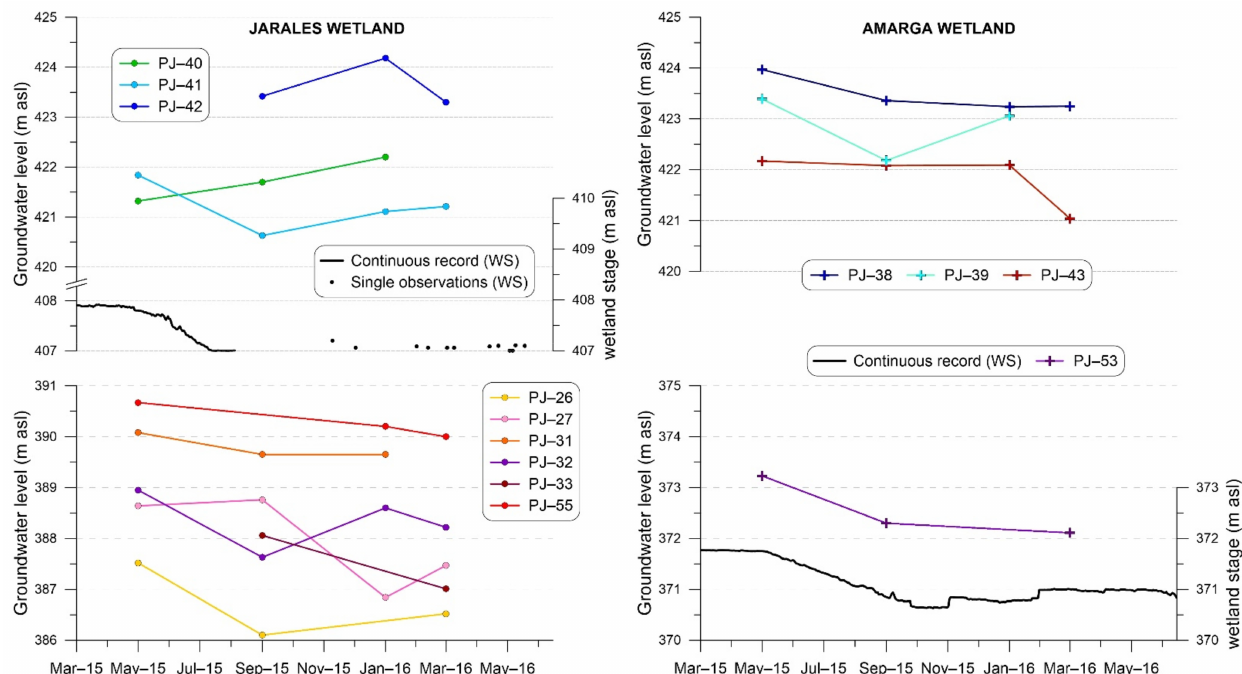
Figure 4. Groundwater level evolution in wells near the Jarales and Amarga wetlands (May 2015–March 2016). Figure 1 shows the location of the wells (in red). The evolution of the Amarga and Jarales stages is also